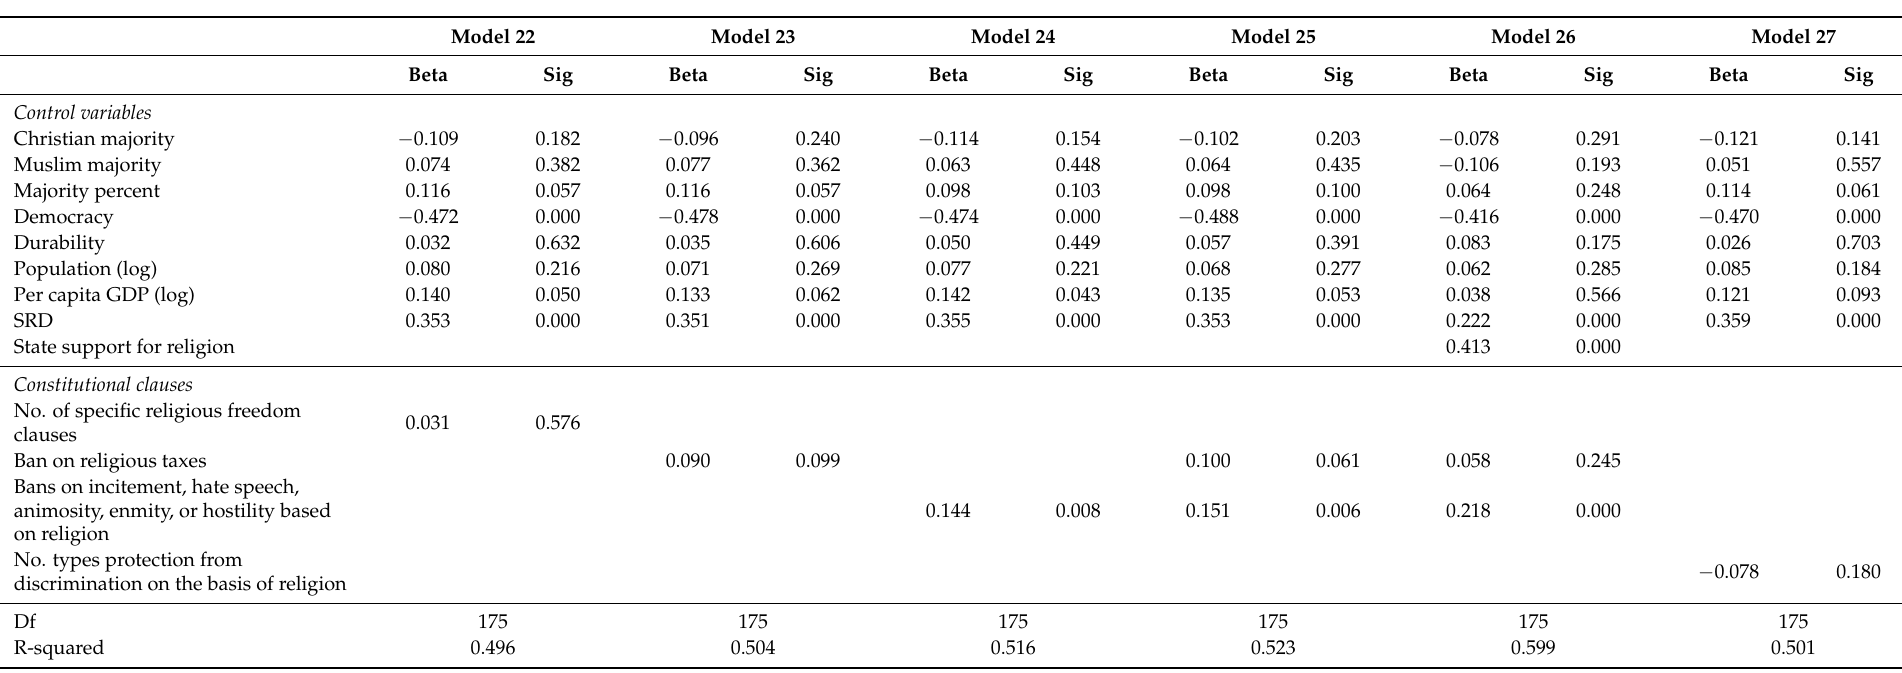
Table 14. OLS regressions predicting the influence of bans on government interference in religion and discrimination on the basis of religion on GRD in